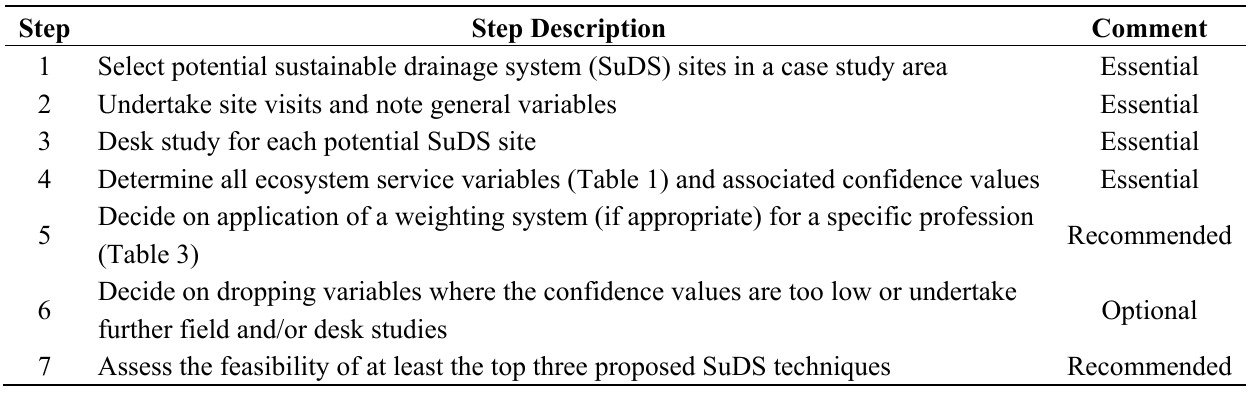
Table 2. Overview of the new ecosystem services assessment